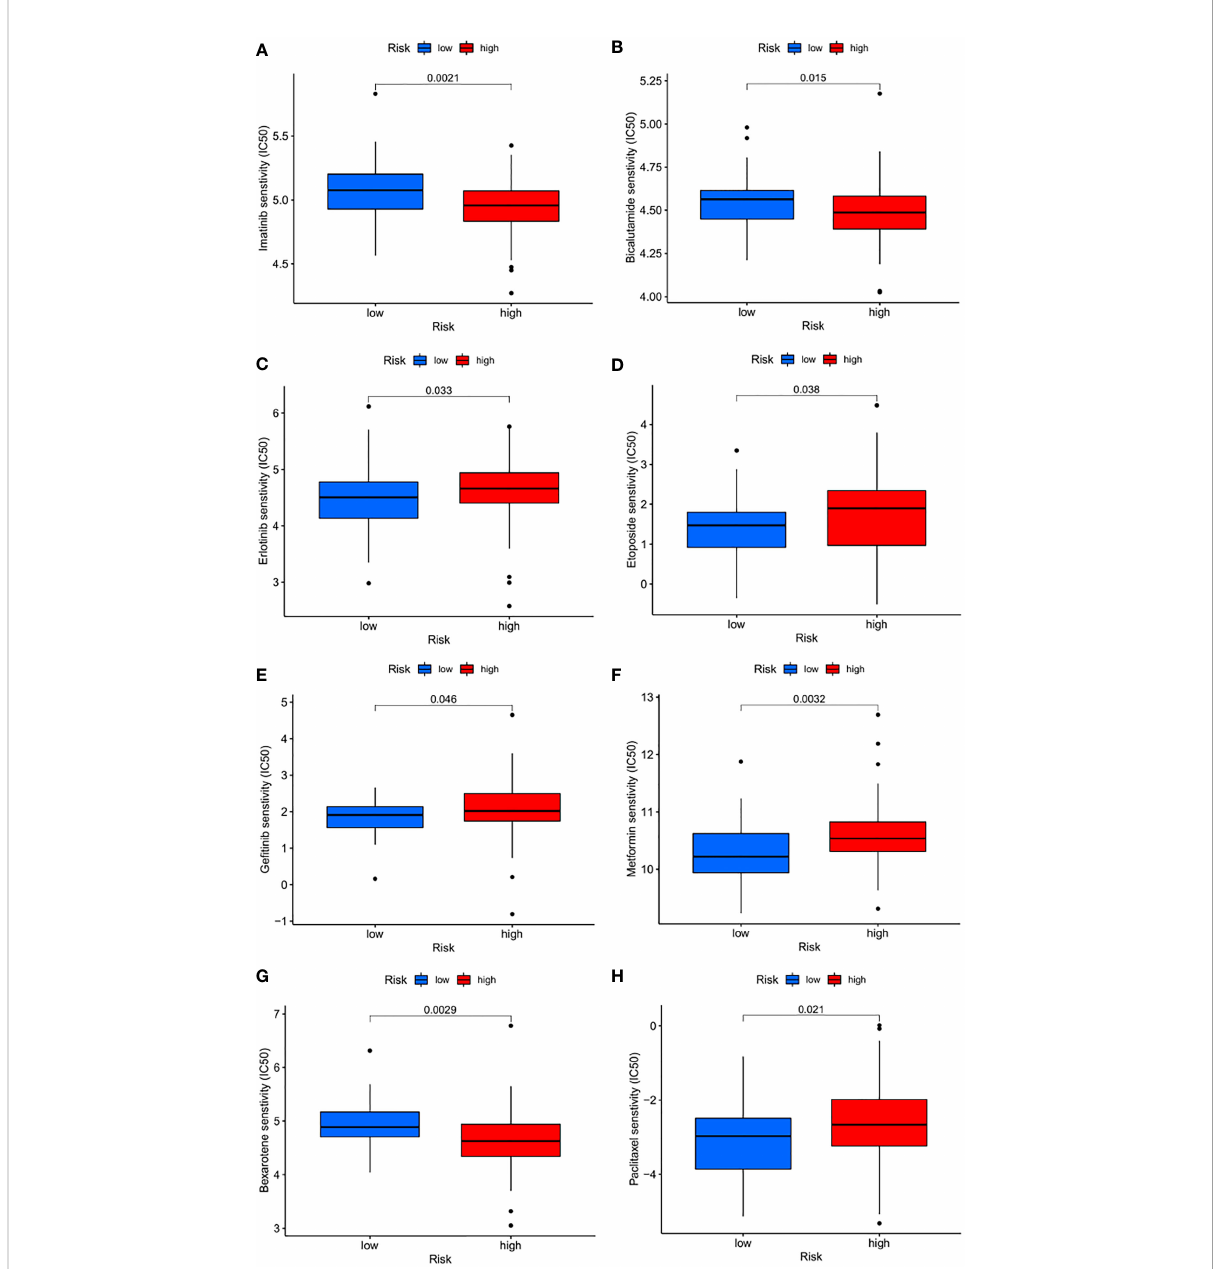
FIGURE 11 Drug sensitivity (A – H) Estimated drug sensitivity in patients with high and low FRLM